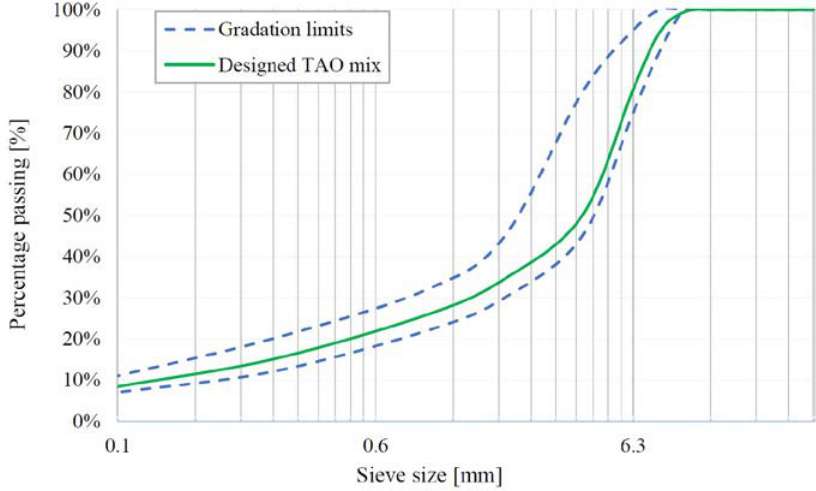
Figure 2. Aggregates distribution and gradation limits.